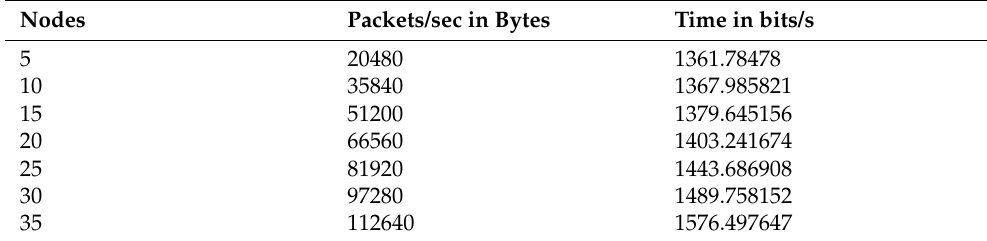
Table 3. Total transmission time for nodes using the Z-MAC scheme.